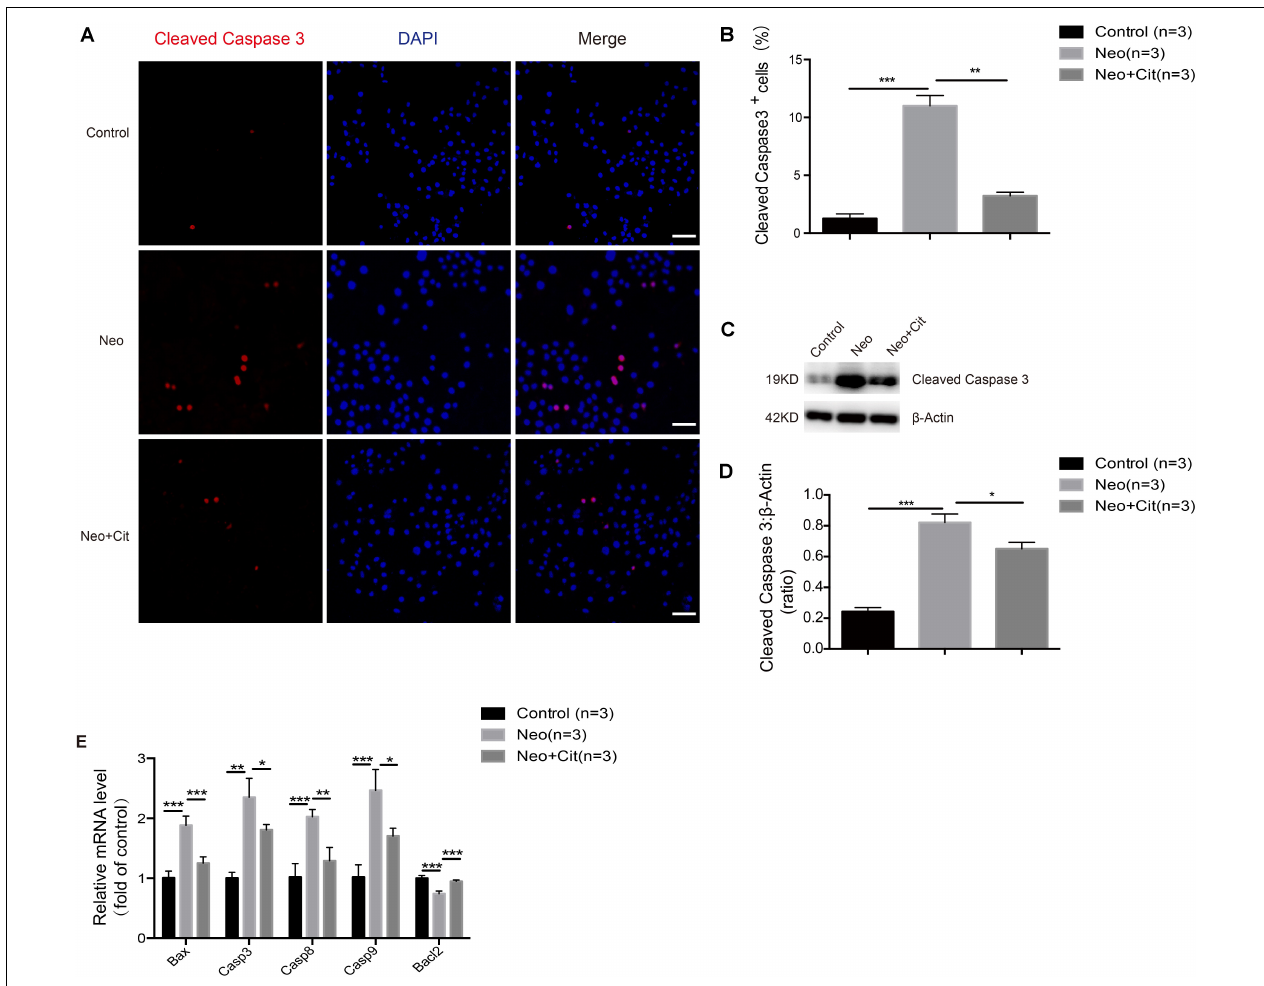
FIGURE 4 | Citicoline reduces the expression of apoptotic factors in HEI-OC-1 cells after neomycin exposure. (A) Cleaved caspase 3 and DAPI double staining confirmed the apoptotic cells after different treatments. (B) Quantification of the numbers of cleaved caspase 3 and DAPI double-positive cells in (A) . (C) Western blot showing that the amount of cleaved caspase 3 in the neomycin-only groups was higher than in the undamaged controls. The amount of cleaved caspase 3 induced by neomycin was significantly reduced by pretreatment with citicoline. (D) Quantification of the western blot in (C) . (E) The mRNA levels of five apoptosis-related genes were analyzed by qRT-PCR normalized to GAPDH and presented as the fold of control levels. Data are shown as mean ± SD. * p < 0.05, ** p < 0.01, *** p < 0.001. Scale bars = 20 µ